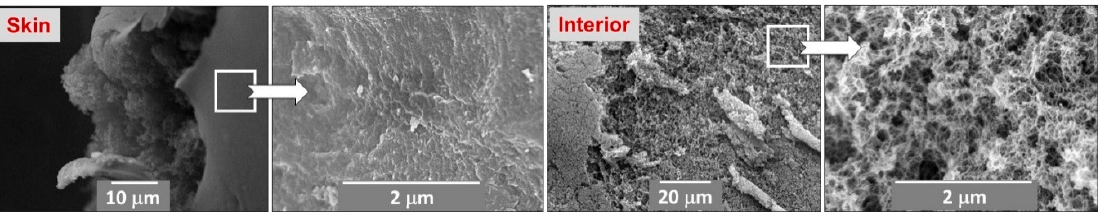
Figure 10. SEM images of spherical PUA aerogel beads at different magnifications: skin and interior, as indicated [94].